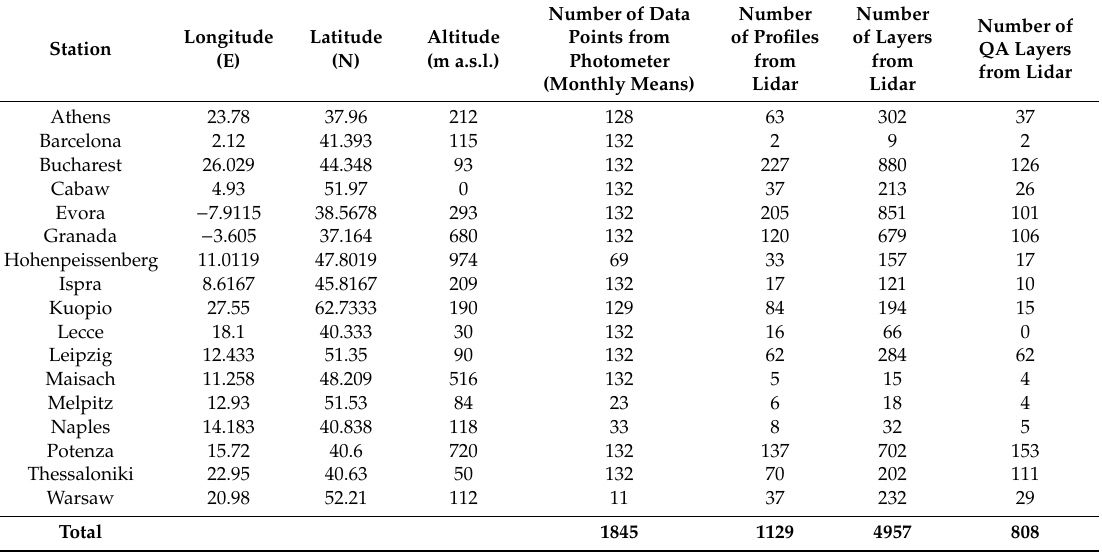
Table 1. List of observing stations and number of data points used (2008–2018). QA: quality assurance.